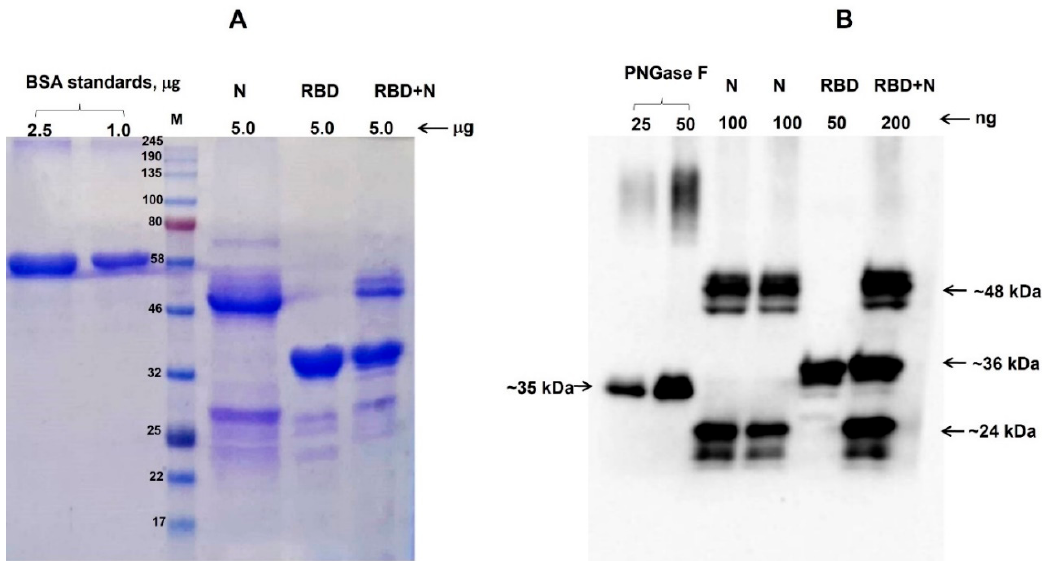
Figure 2. SDS-PAGE ( A ) and Western blot ( B ) analysis of co-expression of RBD with N protein. ( A ) SDS-PAGE analysis of plant-produced, anti-Flag affinity column-purified N, RBD, and N+RBD proteins. N: plant-produced purified N protein; RBD: plant-produced purified RBD protein [4]; RBD + N: RBD + N protein, purified from N. benthamiana plant, co-expressed with N and RBD constructs. BSA standards: 1.0 and 2.5 µ g of BSA protein was loaded as a standard protein. M: color pre-stained protein standard (NEB, Ipswich, MA, USA). ( B ) Western blot analysis of plant-produced, anti-Flag affinity column-purified N, RBD, and N+RBD proteins. The proteins were loaded into wells as indicated; PNGase F: 25 or 50 ng of plant-produced PNGase F was used as a control protein. (Figure 2A was cropped from Figure S6 and Figure 2B was cropped from Figure S7)